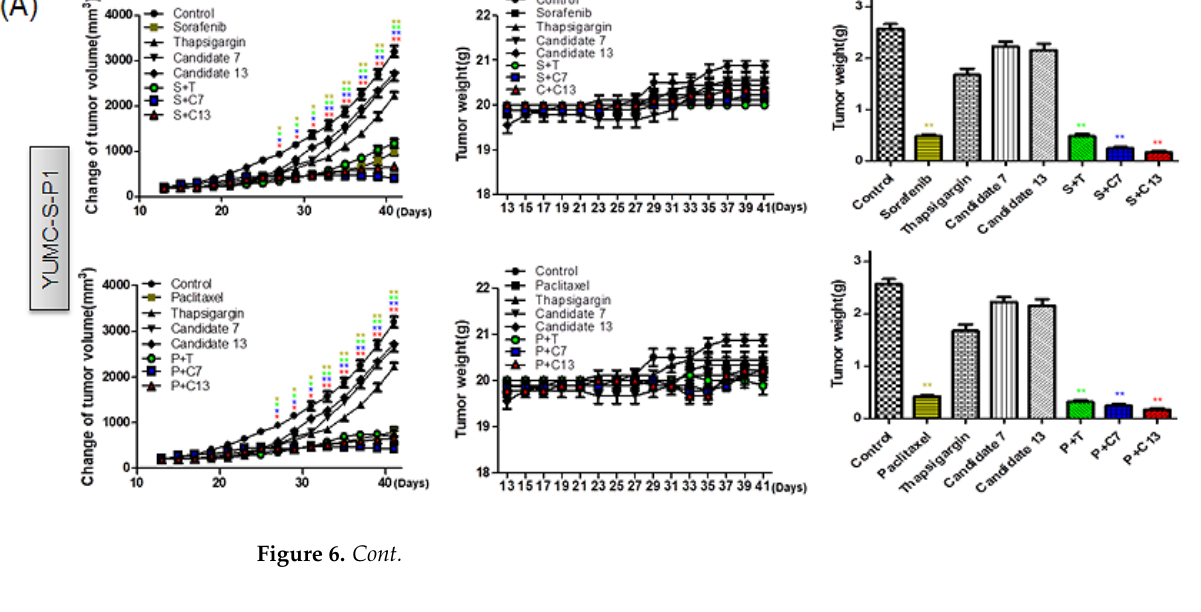
influence mouse body weight (Figure 6B-D, middle, top: YUMC-RP1; middle: -P2; bottom: -P3).